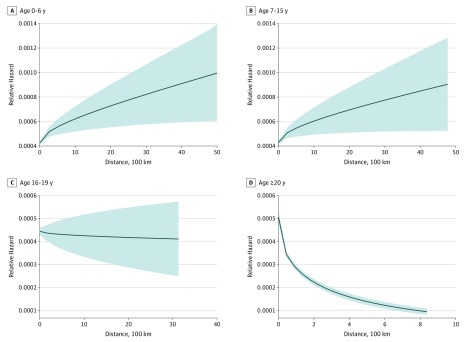
Predicted Hazard of Nonaffective Psychotic Disorder by Cumulative Distance Moved in Each Age PeriodRelative hazard of nonaffective psychotic disorder by cumulative distance between ages 0 to 6 (A), 7 to 15(B), 16 to 19 (C), and 20 or more years (D). Distances are displayed per 100 km up to a total of 1000 km. The shading denotes 95% CIs. Each model is based on the predicted relative hazard following modeling that was adjusted for the covariates listed in adjustment 2 (Table 2). Distances moved before age 16 years displayed a strong nonlinear trend, such that the relative hazard of nonaffective psychosis increased most quickly over shorter move distances (ie, within 30 km) before increasing at a slower rate over longer distances (with less certainty around point estimates). Distance moved between age 16 to 19 years was best modeled as a linear predictor, with no significant differences in the relative hazard of nonaffective psychosis observed by distance (Table 2). Cumulative distances moved after age 20 years were associated with a strong, nonlinear reduction in the relative hazard of nonaffective psychosis, particularly for moves up to approximately 30 km.